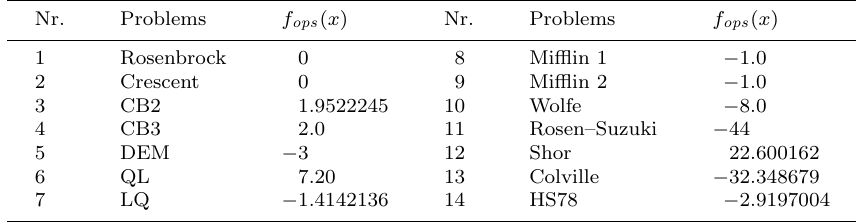
Table 1. The test problems and global minimum values of the functions.